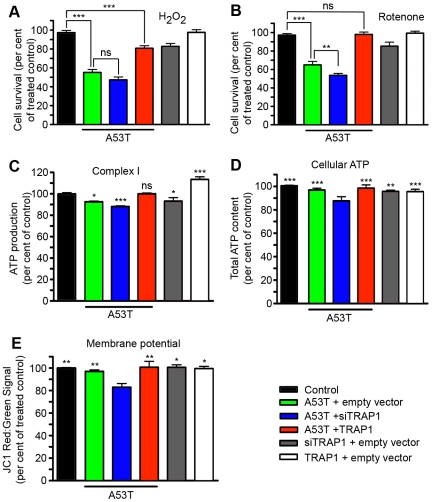
Alterations in TRAP1 levels influence [A53T]α-Synuclein-induced sensitivity to oxidative stress and mitochondrial effects in HEK293 cells.HEK293 cells were transfected with plasmids promoting [A53T]α-Synuclein or TRAP1 expression. Empty vector transfection served as control. In addition, RNAi-mediated silencing of endogenous TRAP1 was induced (siTRAP1). Cells transfected with indicated plasmid combinations were treated with (A) hydrogen peroxide (100 µm) or (B) rotenone (200 µM) to induce oxidative stress. Cell numbers were analyzed to monitor survival. (C–E) HEK293 without oxidative stress treatment overexpressing the indicated proteins, or with RNAi-mediated silencing of TRAP1 were analyzed for (C) ATP production via Complex I, (D) total ATP content, and (E) mitochondrial membrane potential. Statistical analysis of displayed bar graphs was performed using ANOVA followed by Newman-Keuls Multiple Comparison Test. (A, B) Biologically relevant comparisons are indicated in bar graphs. (C) Differences compared to control are indicated. (A, B, C) A detailed summary of all comparisons is summarized in Figure S8. (D, E) Only cells with [A53T]α-Synuclein expression and TRAP1 reduction displayed significant differences in statistical analysis as indicated in graph. All other comparisons were not significant. *p<0.05; **p<0.01; ***p<0.001; ns = not significant.